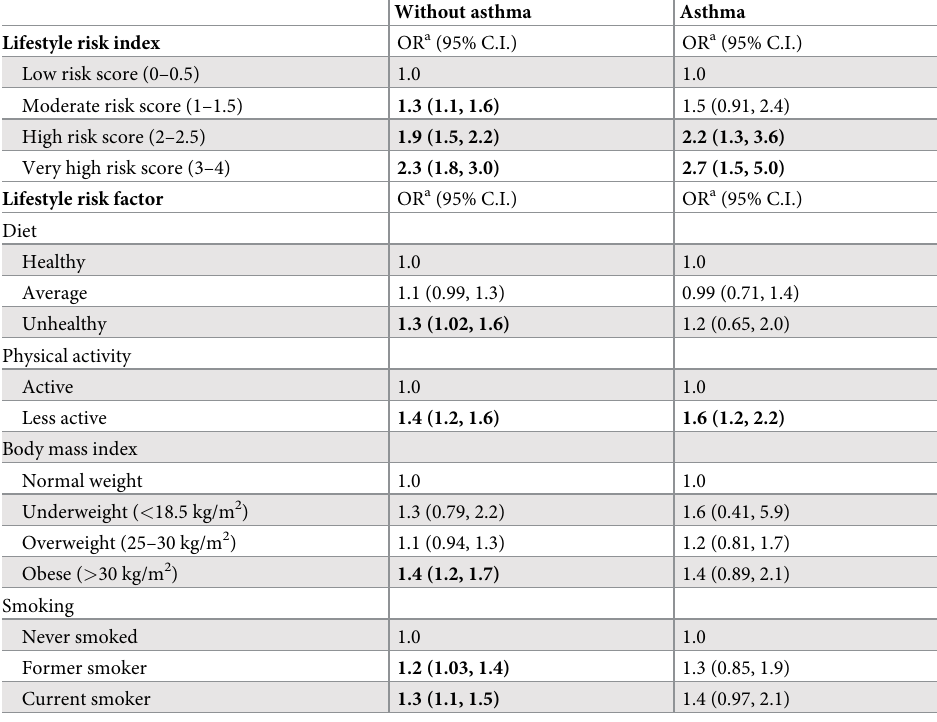
a Adjusted for gender, age, educational level and other chronic lung